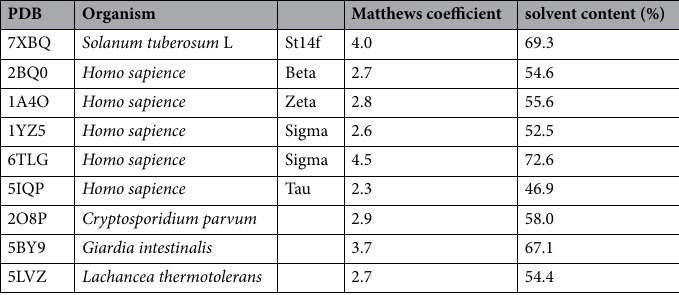
Table 2. Matthews coefficients and solvent content of 14-3-3 free form crystal.